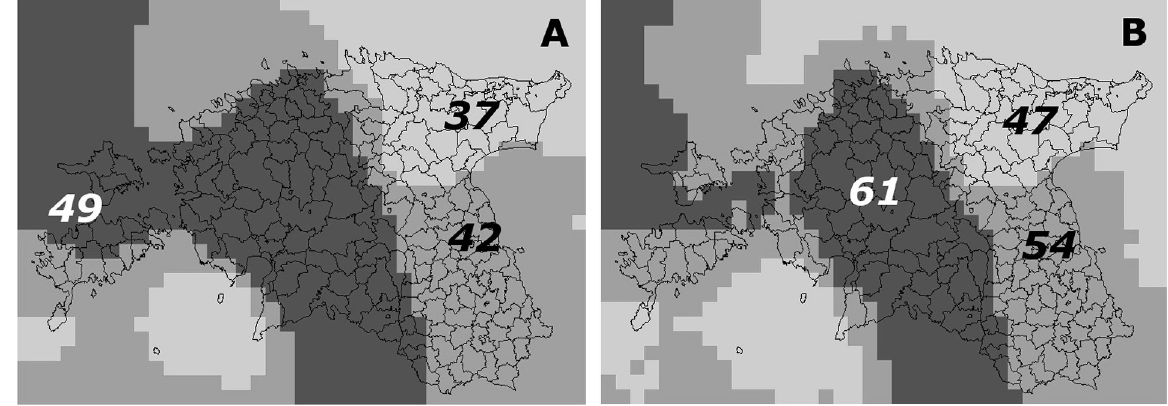
Fig. 10. Winter (DJF) precipitation sum (mm) and regions during the reference period 1971–2000 ( A ) and according to RCP8.5 for the period 2071–2100 ( B